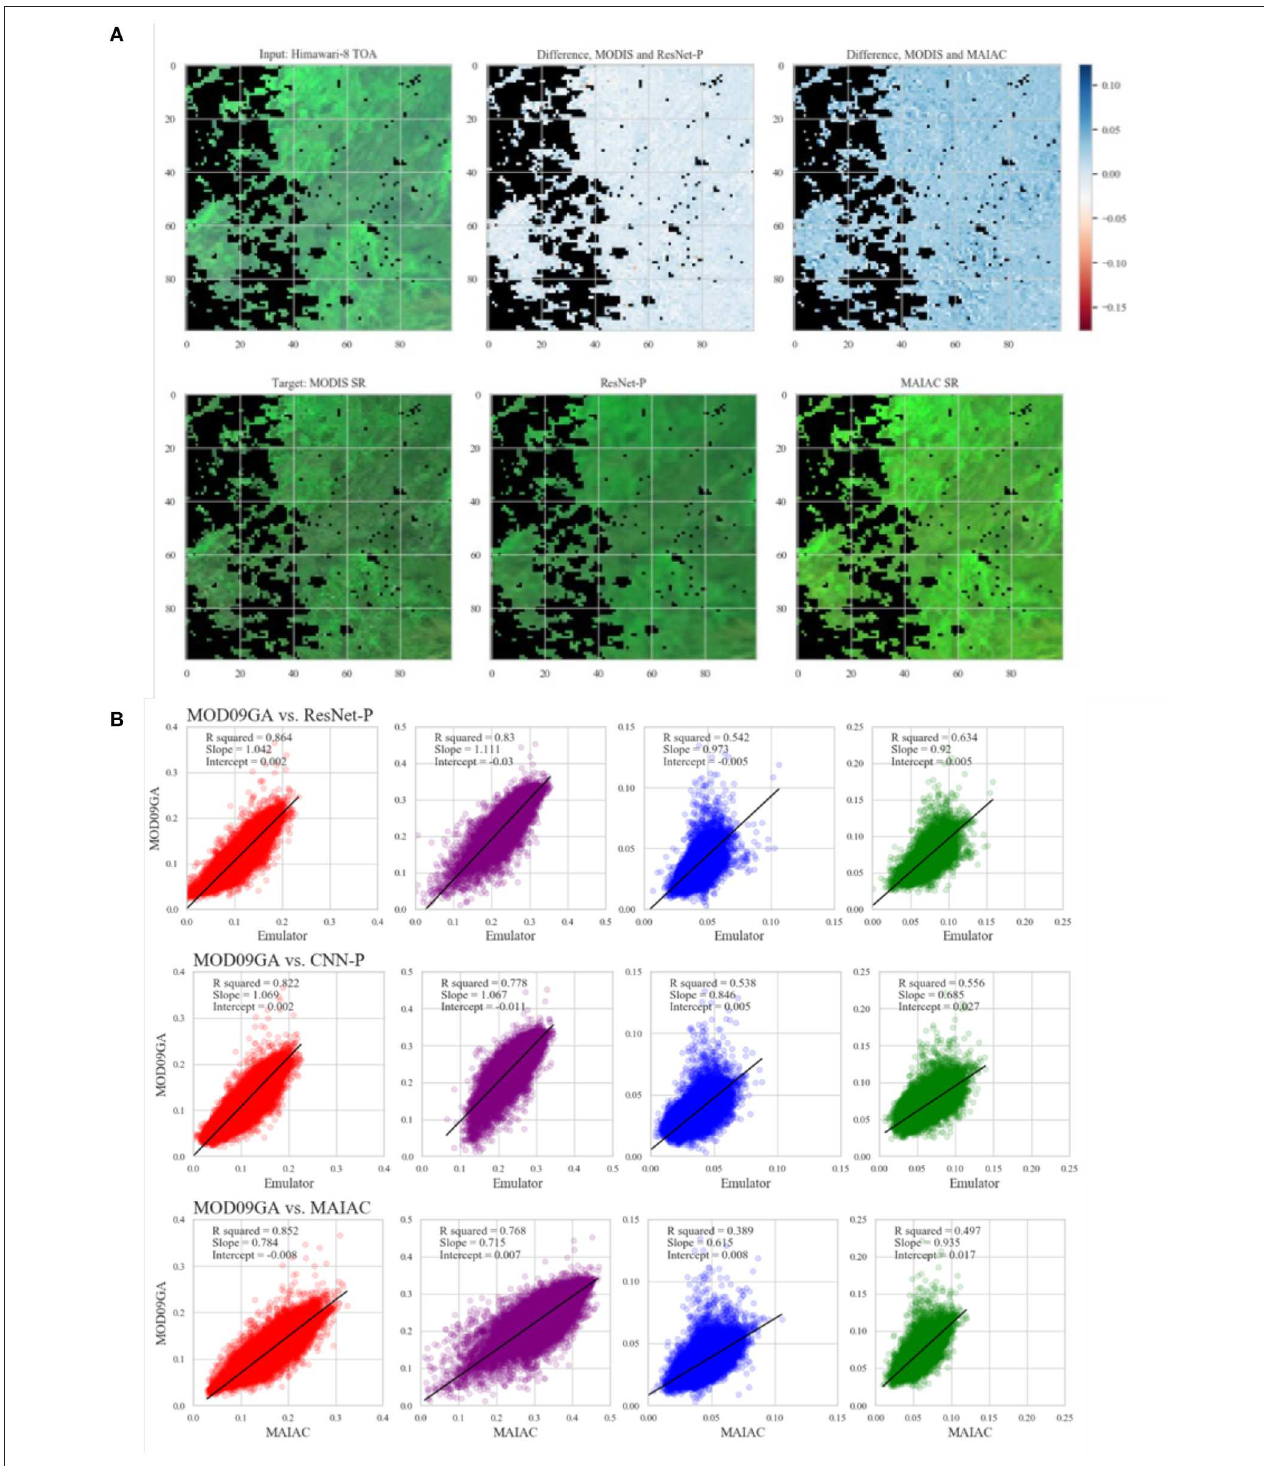
FIGURE 2 | (A) Counterclockwise from top left: input TOA reflectance, target MODIS SR, emulator SR, MAIAC SR, visualization of difference between MODIS and two SR products. (B) Agreement between model predictions (ResNet-P, CNN-P, and MAIAC) and MODIS SR for 4 bands. Results are presented for one typical 600 × 600 pixel image from the testing